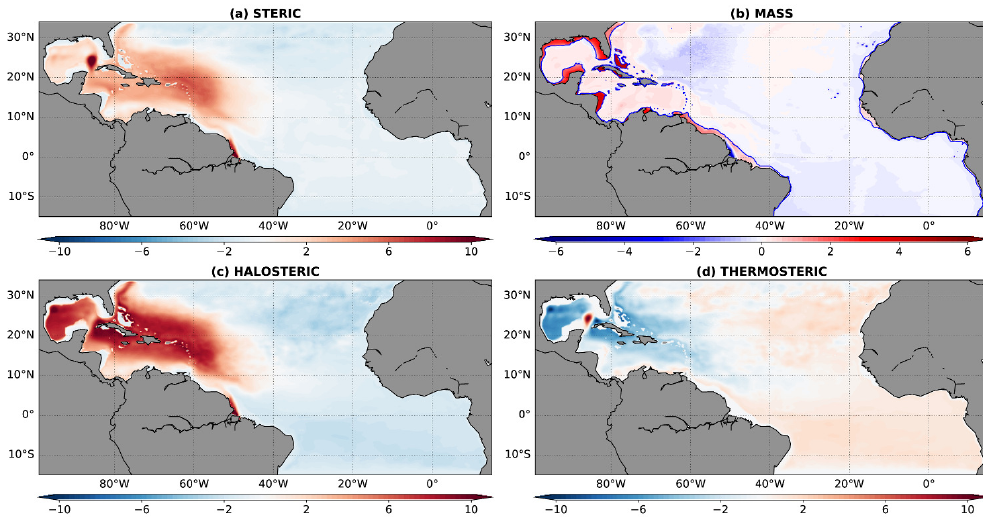
Figure 6. Contributions to the MDT anomaly between REF and NOAMZ: ( a ) steric anomaly, ( b ) mass anomaly (the bathymetry contour 100 m is overlaid in blue), ( c ) halosteric anomaly and ( d ) thermosteric anomaly. Units are in centimeters. The considered period is 1993–2015.